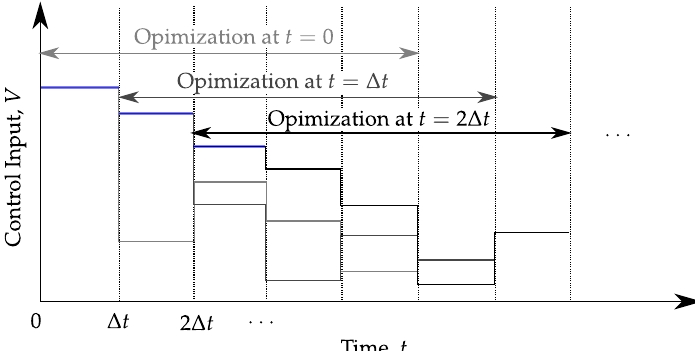
Figure 1. Control input in MPC. The blue histogram shows control input in MPC, and the three gray histograms show optimal control inputs obtained at t = 0, ∆ t , and 2 ∆ t .